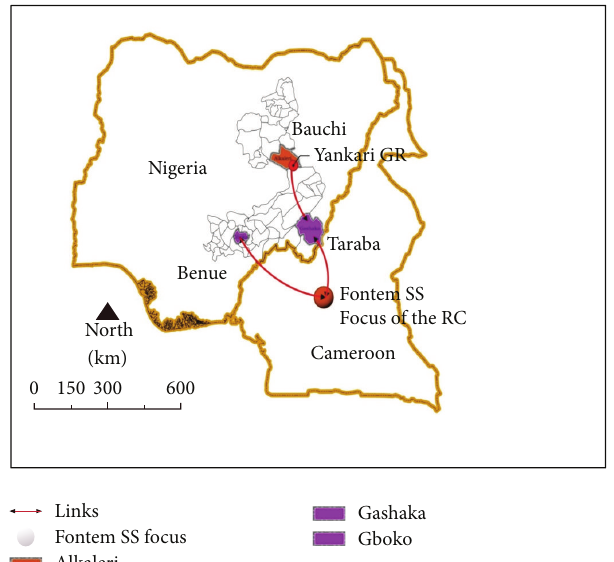
Figure 1: Links between the study sites and possible sources of T. b. gambiense infections. GR: game reserve; RC: Republic of Cameroon; SS: sleeping